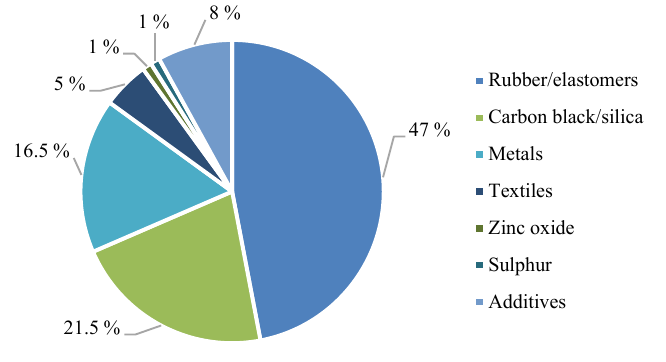
Fig. 1. Composition by Mass of EU Car [4] (Note: the amount of textile fibre in Cars varies 5 –10 % (mostly accepted as 10 %). It is important to understand the composition of the End -of-life Tyre. Authors [9] and [10]